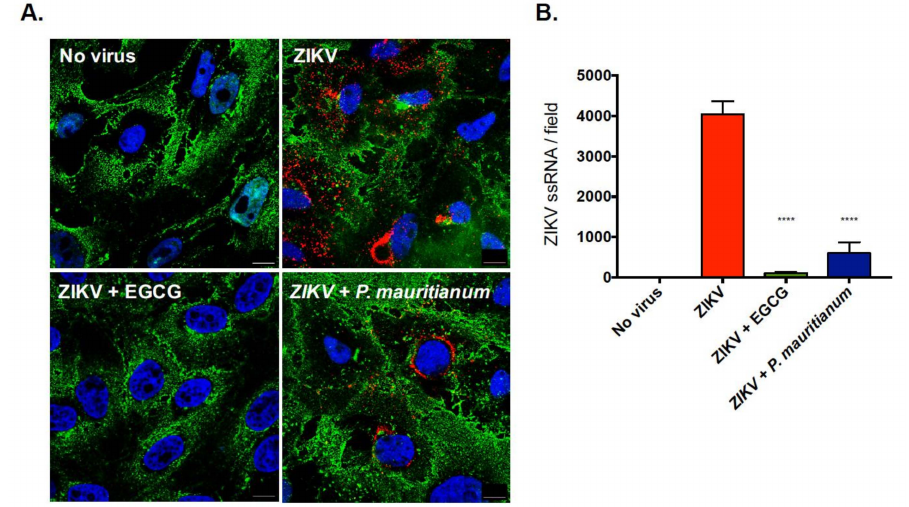
Figure 3. P. mauritianum extract inhibits the production of ZIKV ssRNA. ZIKV-MR766 particles were incubated with the P. mauritianum extract for 1 h at 37 ◦ C. The EGCG treatment (100 µ M) was used as positive control. Vero cells were left uninfected or were infected at an MOI of 1 for 24 h. ( A ) Cells were processed for FISH using a probe specific for viral RNA (red) and then stained with NucBlue to visualize the nuclei (blue). Cell membranes were stained with AF488-conjugated wheat germ agglutinin. Images are representative of three independent experiments. Scale bars are 20 µ m. ( B ) Quantification of ZIKV ssRNA spots counted per field (fields contained on average 300 cells) from the experiments represented in the images. Data are means ± SD of three independent experiments. Statistical analyses were performed using a one-way ANOVA and Dunnett’s test for multiple comparisons (**** p <